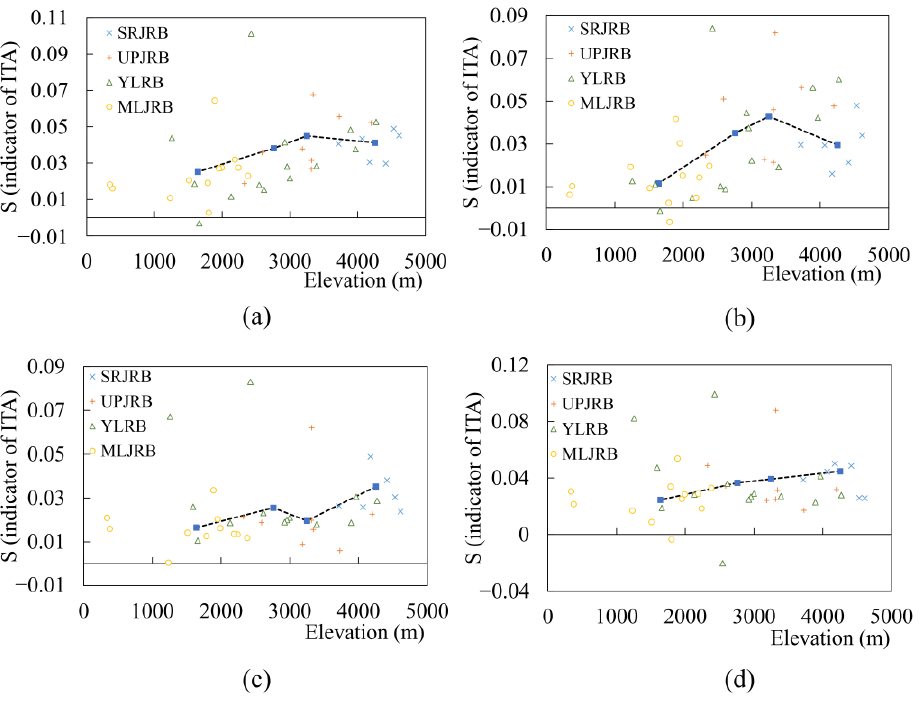
Figure 9. Correlation between elevation and temperature time series for ( a ) annual minimum temperature, ( b ) low category annual minimum temperature, ( c ) annual maximum temperature, and ( d ) high category annual maximum temperature during 1961–2016 in the Jinsha River Basin (JRB). Black dashed lines show the average values for all sub-basins.